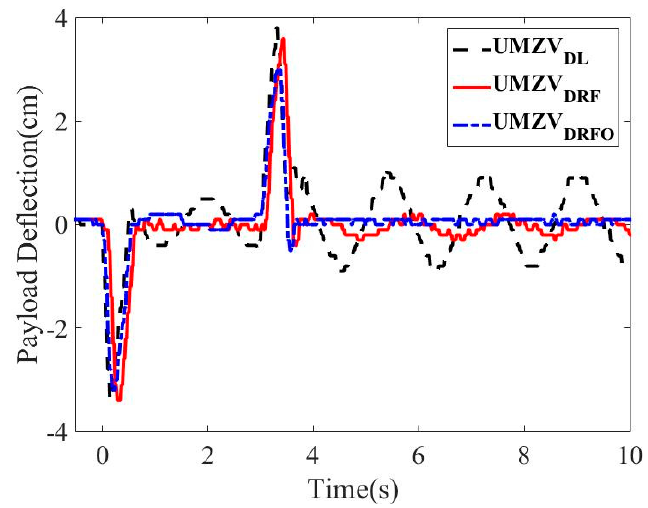
Figure 15. Experimental velocity commands.